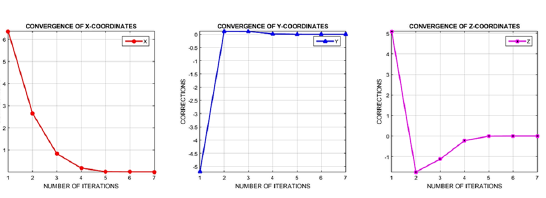
Figure 6. a) The simulated 3D scene. b) The simulated equirectangular panorama at one station. Starting values are selected as: to verify the robustness of the solution. The proposed method using the derived oblique angles is applied with the nonlinear least squares adjustment as applied with the perspective images of section 2.2. The correction iterations converged to zero after five iterations as shown in Figure 7.